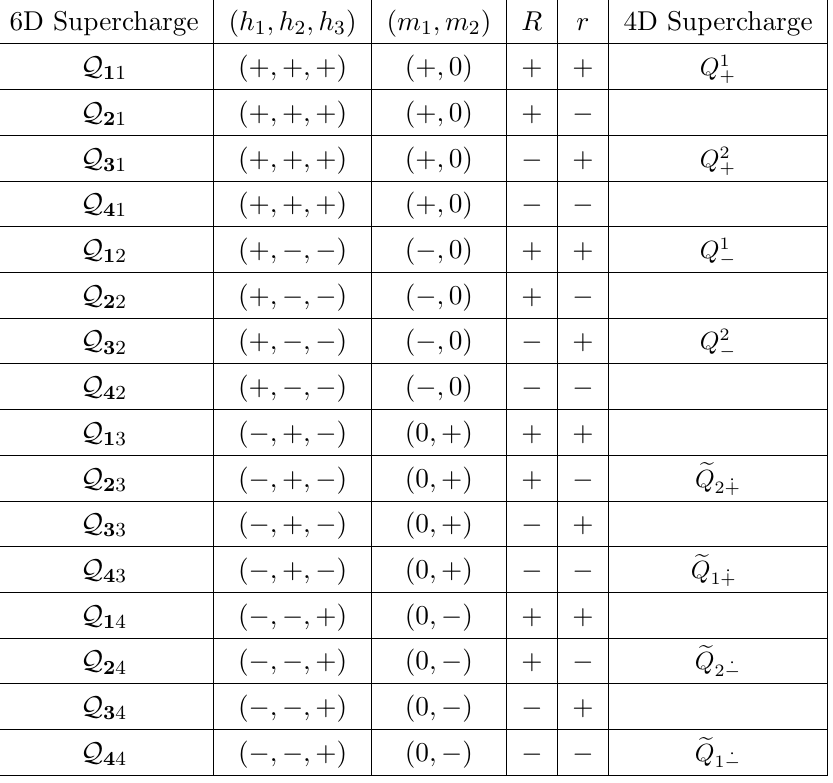
Table 3 . Summary of supercharge quantum numbers in 6D and the 4D embedding. All orthogonal- basis quantum numbers have magnitude one half. The four-dimensional subalgebra acts on the h 2 and h 3